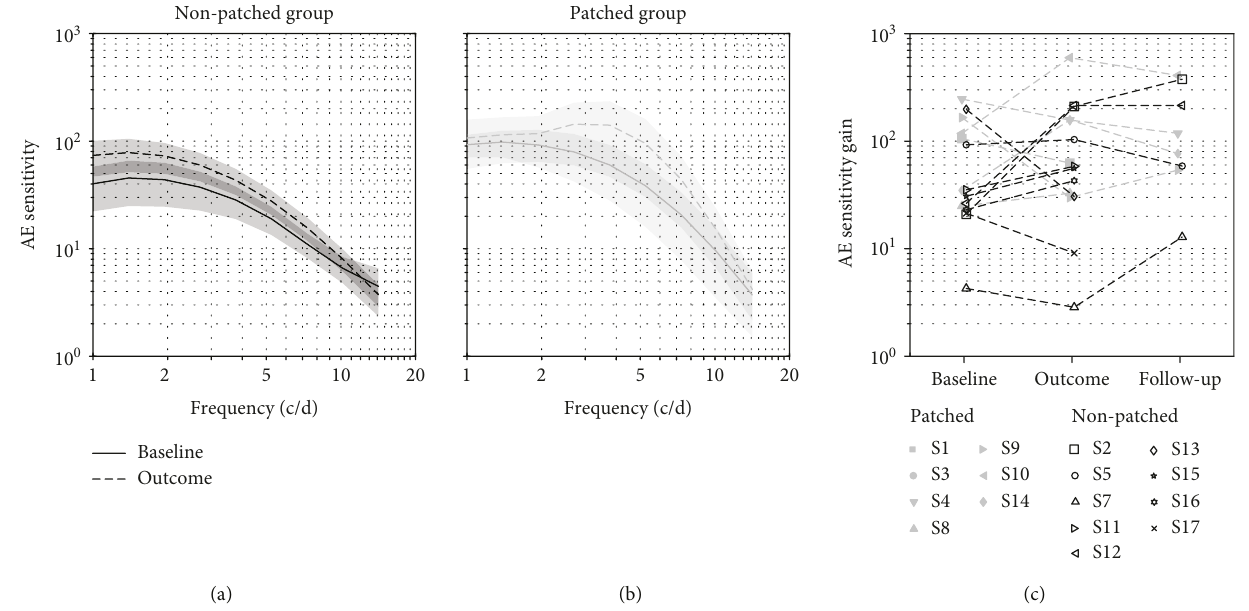
Figure 4: Contrast sensitivity improvement. (a) Contrast sensitivity of the amblyopic eye as a function of spatial frequency at baseline (solid line) and at the training outcome (dashed line) for the nonpatched group. Grey areas represent ± standard error. (b) Contrast sensitivity of the amblyopic eye as a function of spatial frequency at baseline and at the training outcome for the patched group. Same line style as (a). (c) Individual sensitivity gain of the participants at baseline, at the outcome of the training, and at the follow-up control one month later. Participants from the patched group are indicated with fi lled grey symbols, and participants of the nonpatched group with open black symbols.